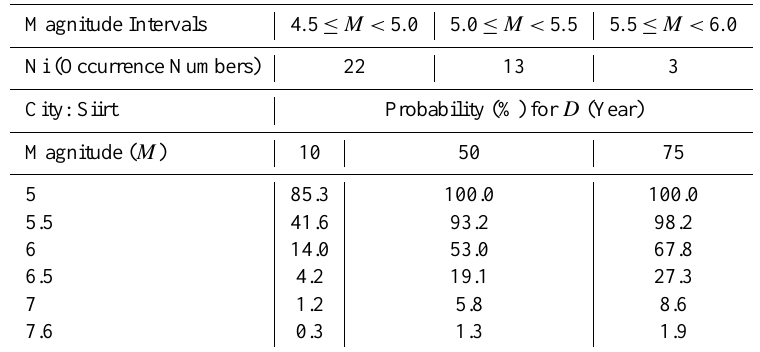
Table 3t. Earthquake occurrence probability (%) for D (Year) for Siirt